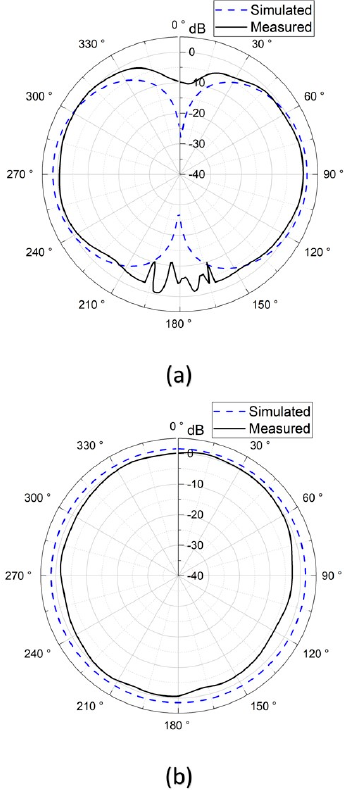
Figure 15. The gain patterns of the single-connector stent antenna in ( a ) the E-plane, and ( b ) the